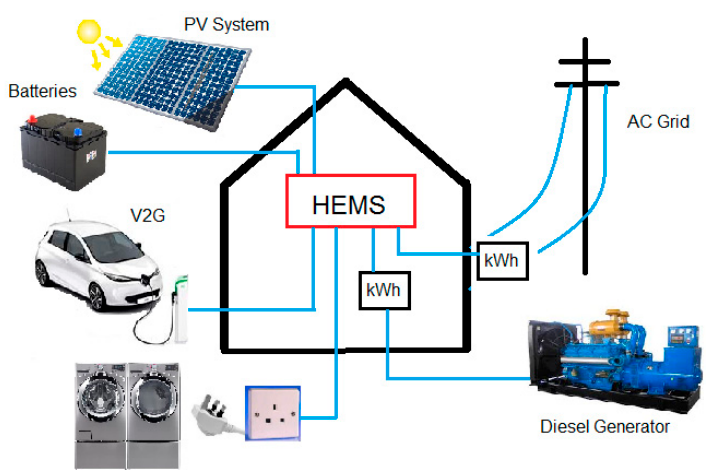
Figure 2. Residential microgrid scheme.